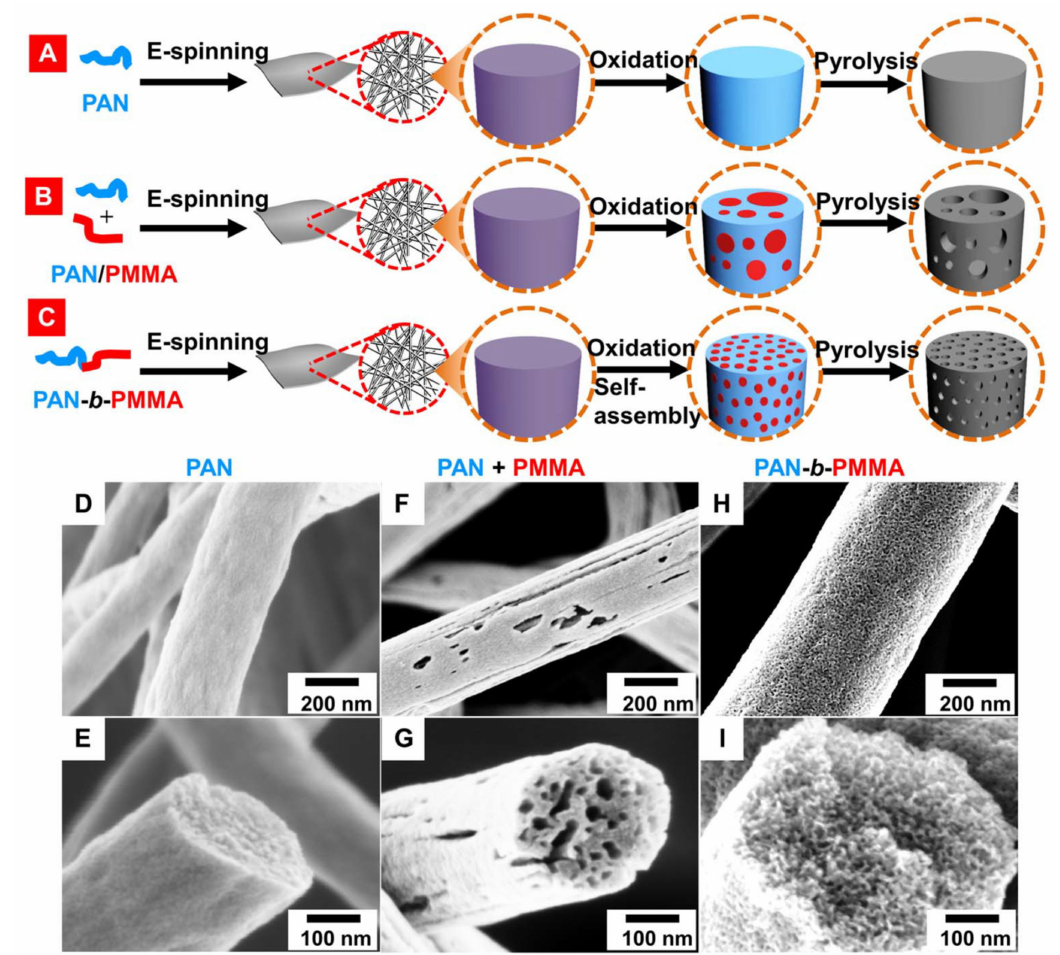
Figure 1. Schematic and scanning electron microscopic images showing how to make solid and porous carbon fibers. ( A ) PAN was E-spun into a fiber mat first. Then, oxidation at 280 ◦ C in air led to the crosslinking of PAN (blue). After that, the fiber was treated at 800 ◦ C in N 2 to produce carbon fibers (gray). A single polymer fiber (purple) was magnified for clear demonstration. ( B ) PAN was mixed with the sacrificial PMMA (red) to form a polymer blend. After oxidation, the phase separation of the polymer blend produced two domains. During pyrolysis, PMMA was removed, resulting in random-sized pore formation. ( C ) The phase separation in PAN-b-PMMA block copolymer resulted in uniform PMMA domains (red) in the PAN matrix (blue) via oxidation and self-assembly. After pyrolysis, the PCFs showed well-controlled and uniformly distributed pores. SEM images of the carbon fibers from ( D , E ) PAN, ( F , G ) PAN / PMMA, and ( H , I ) PAN-b-PMMA. Reproduced under